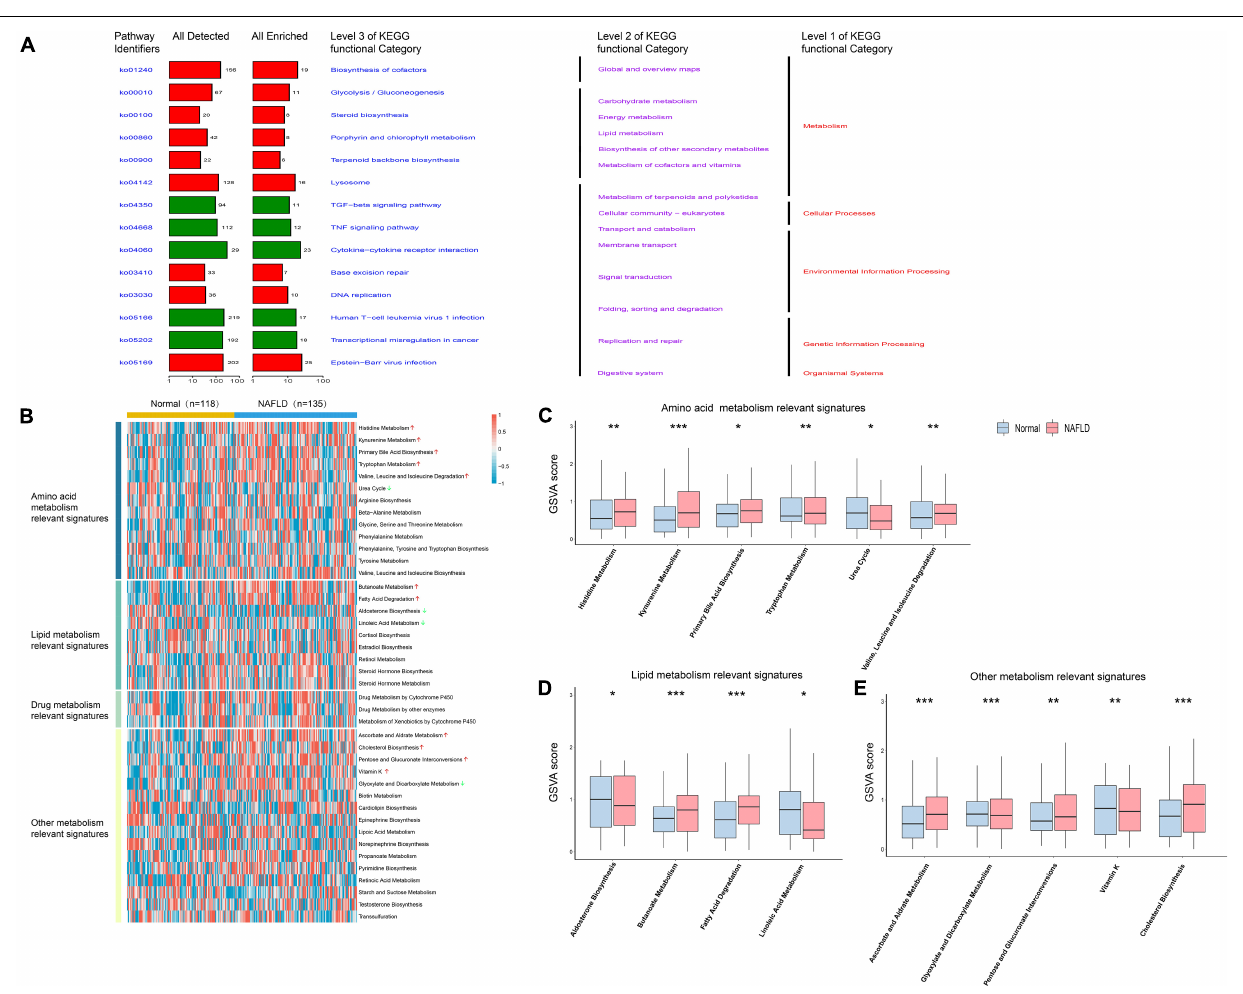
FIGURE 2 | Pathway analysis of NAFLD pathogenesis. (A) Pathway analysis of differentially expressed genes. The red bar represents the functional pathway enriched by up-regulated genes, while the green bar represents the functional pathway enriched by down-regulated genes. (B) Heatmap of the specific metabolism-associated pathways. (C) Boxplot of the signature score for differentially amino acid metabolism-associated pathways. (D) Boxplot of the signature score for differentially lipid metabolism-associated pathways. (E) Boxplot of the signature score for differentially other metabolism-associated pathways. * p < 0.05, ** p < 0.01 and *** p <